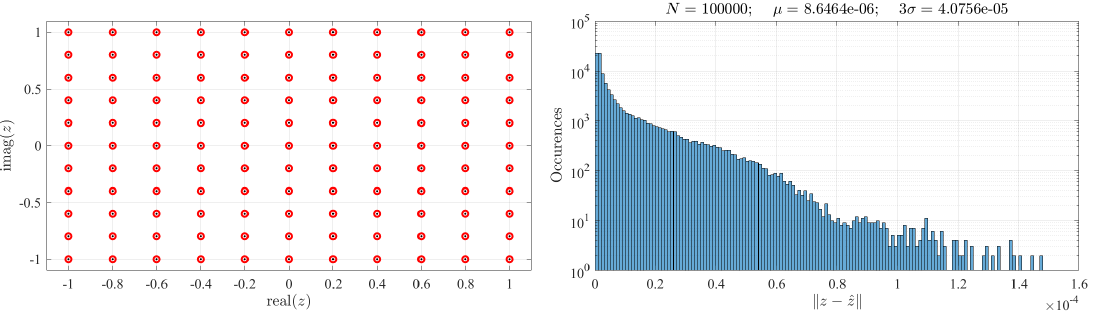
Figure 10. Approximate inverse function tests result.